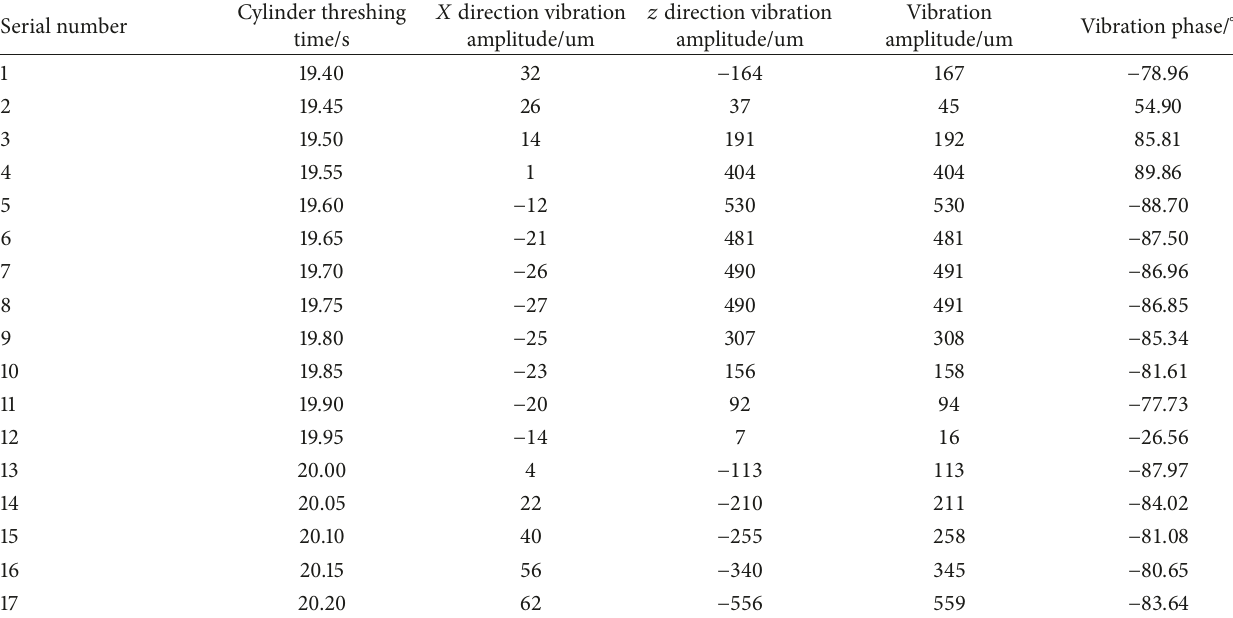
Table 4: 𝑋 and 𝑍 direction vibration values of rice threshing